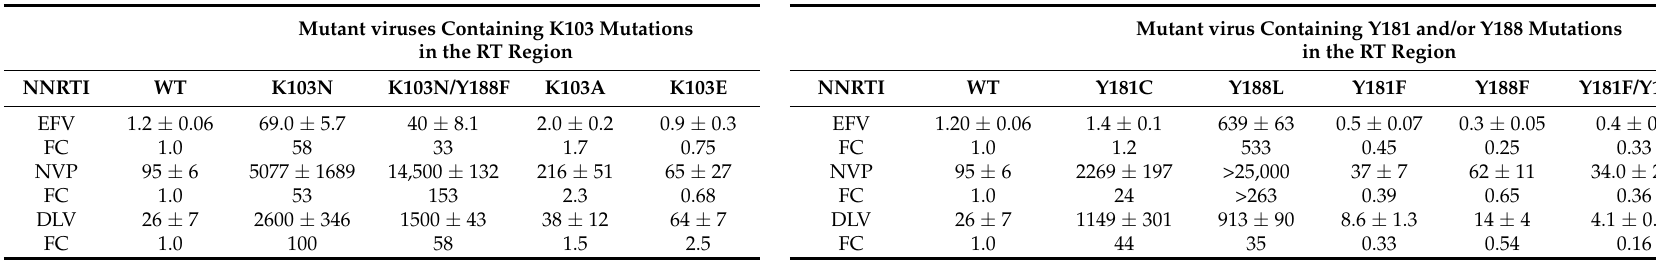
Mutant virus Containing Y181 and/or Y188 Mutations in the RT